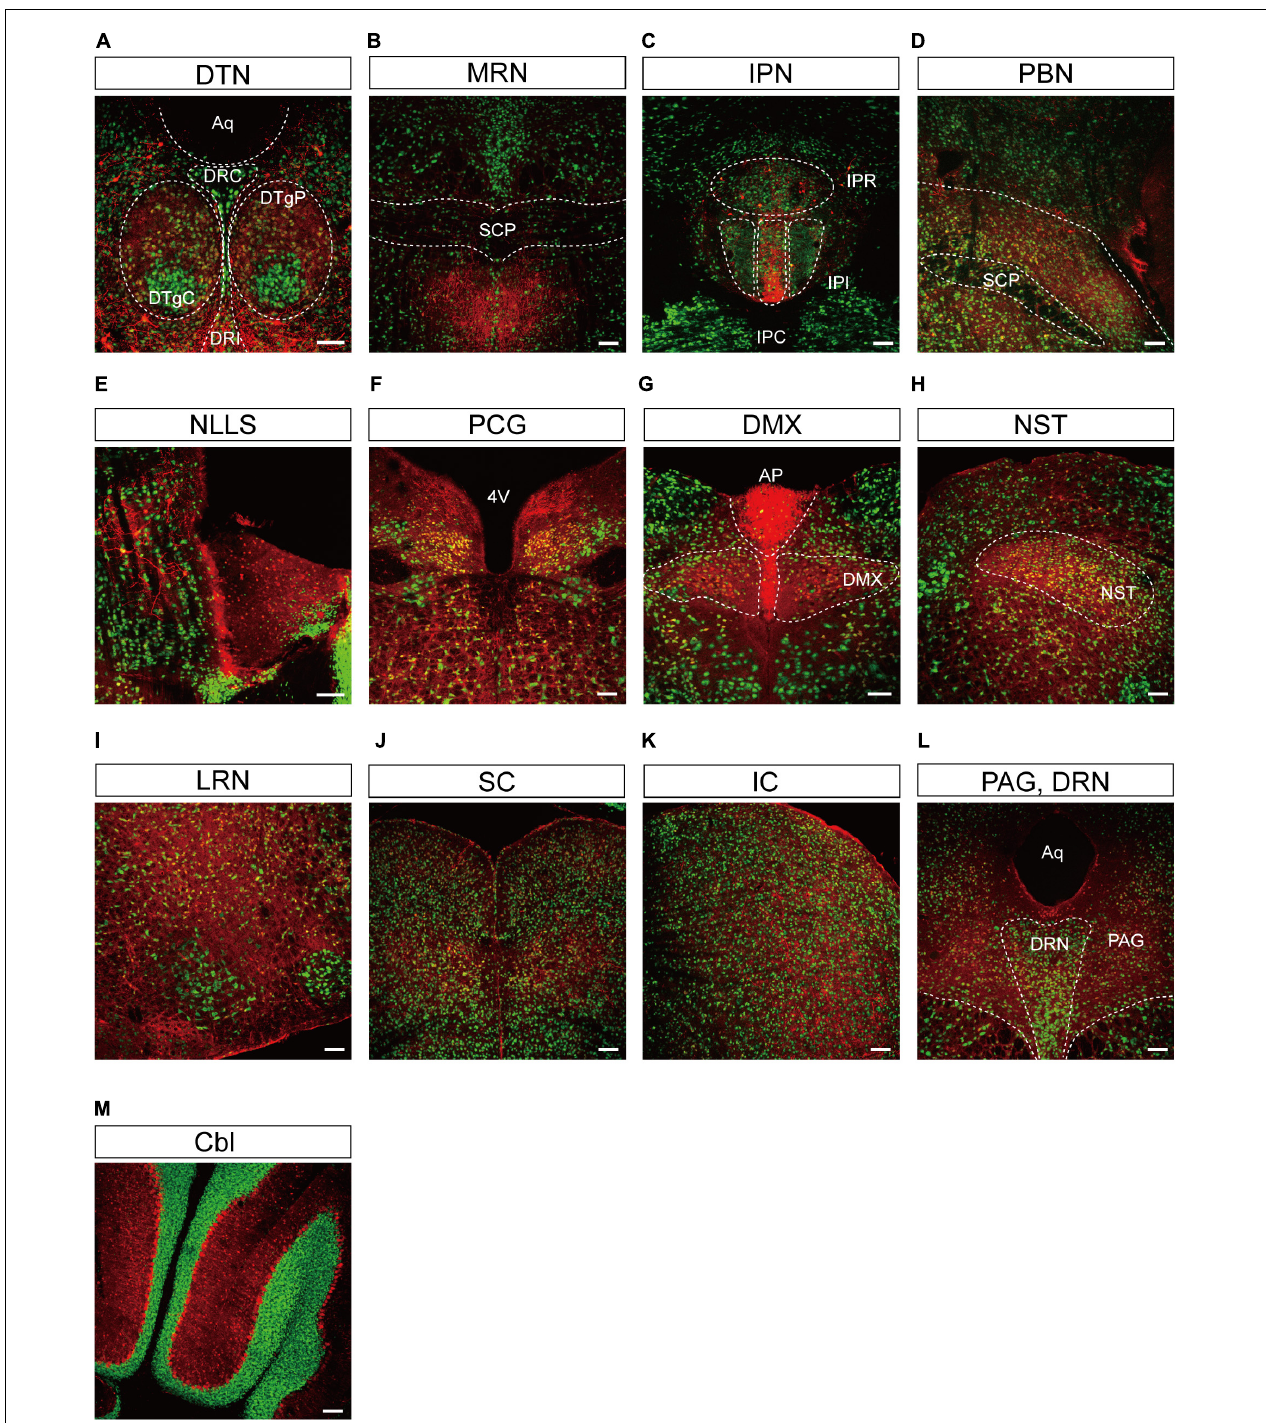
FIGURE 5 | Representative confocal images showing tdTomato fluorescence in the midbrain, hindbrain, and cerebellum of T1r2 -tdTomato mice. (A) Dorsal tegmental nucleus (DTN). The caudal (DRC), interfascicular (DRI), central (DTgC), and pericentral parts (DTgP) are marked. Aqueduct (Aq), (B) the median raphe nucleus (MRN) and superior cerebellar peduncles (SCP) are indicated, (C) interpeduncular nucleus (IPN). The rostral (IPR), caudal (IPC), and intermediate subnucleus (IPI), (D) parabrachial nucleus (PBN), (E) nucleus of the lateral lemniscus (NLLS), (F) pontine central grey (PCG). 4 th ventricle (4V), (G) AP and dorsal motor nucleus of the vagus nerve (DMX), (H) nucleus of the solitary tract (NST), (I) lateral reticular nucleus (LRN), (J) superior colliculus (SC), (K) inferior colliculus (IC), (L) periaqueductal gray (PAG) and dorsal raphe nucleus (DRN), and (M) Cerebellum (Cbl). White dotted lines indicate the border of nearby areas. Anti-NeuN signals (green); tdTomato (red). Scale bar, 100 µ